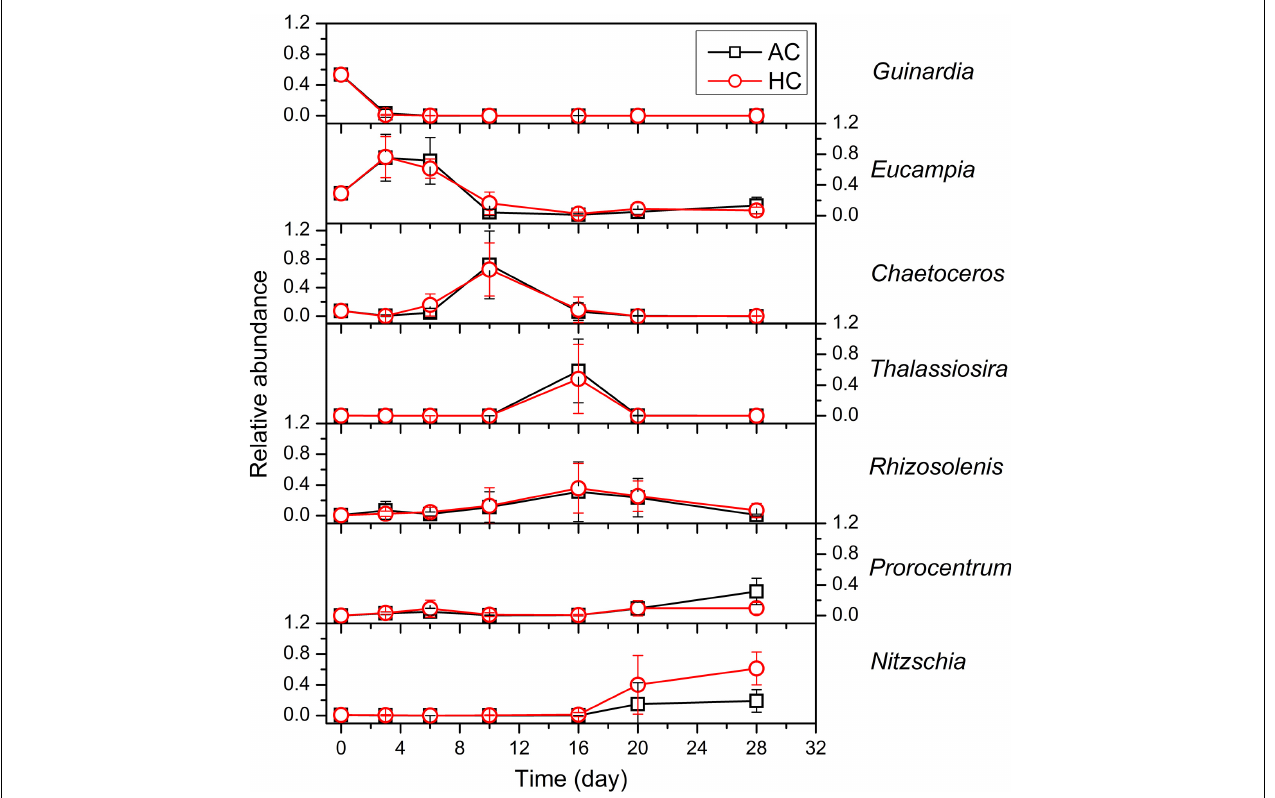
FIGURE 6 | The succession of the dominant phytoplankton at genus level in HC (1000 ppmv) and AC ( ∼ 410 ppmv) treatments. Data are means ± SD of replicates for HC treatments and for AC